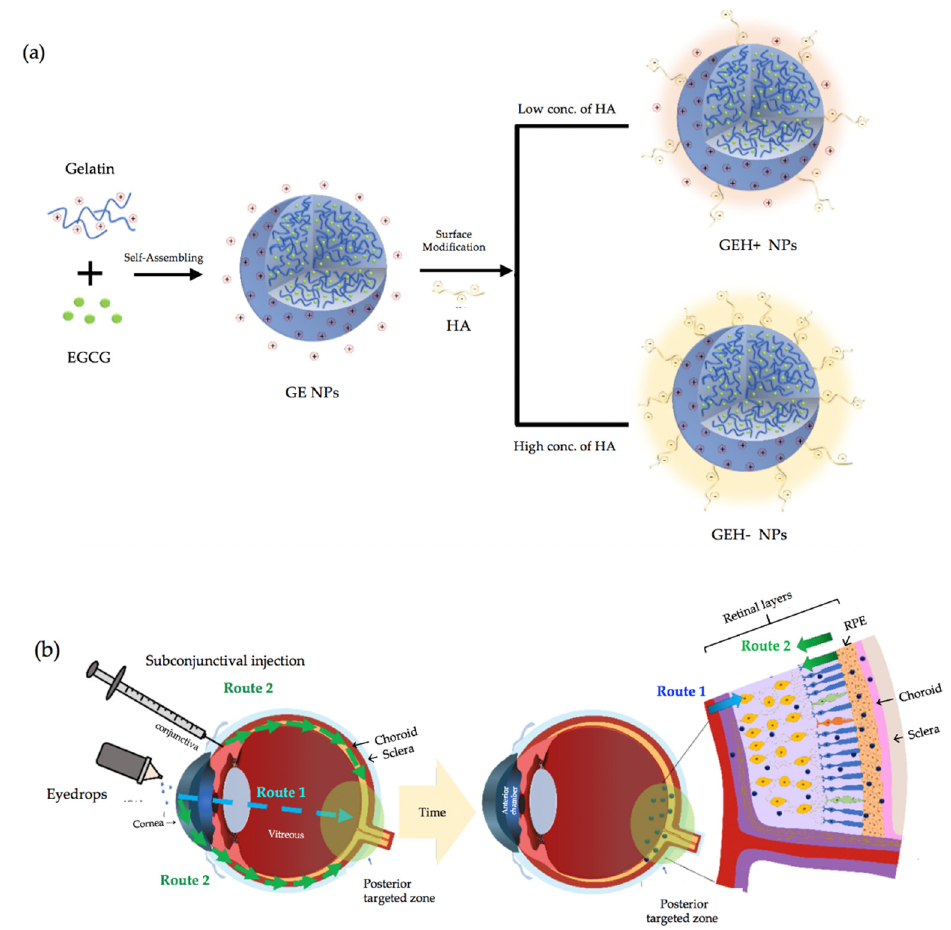
Figure 1. Schematic drawing of ( a ) self-assembled GE NPs with different HA addition forming cationic/ionic surface, and ( b ) two methods (eyedrops and subconjunctival injection) which were used to evaluate delivery of nanoparticles to the posterior eye segment. (Route 1: trans-corneal route, Route 2: non-corneal route).